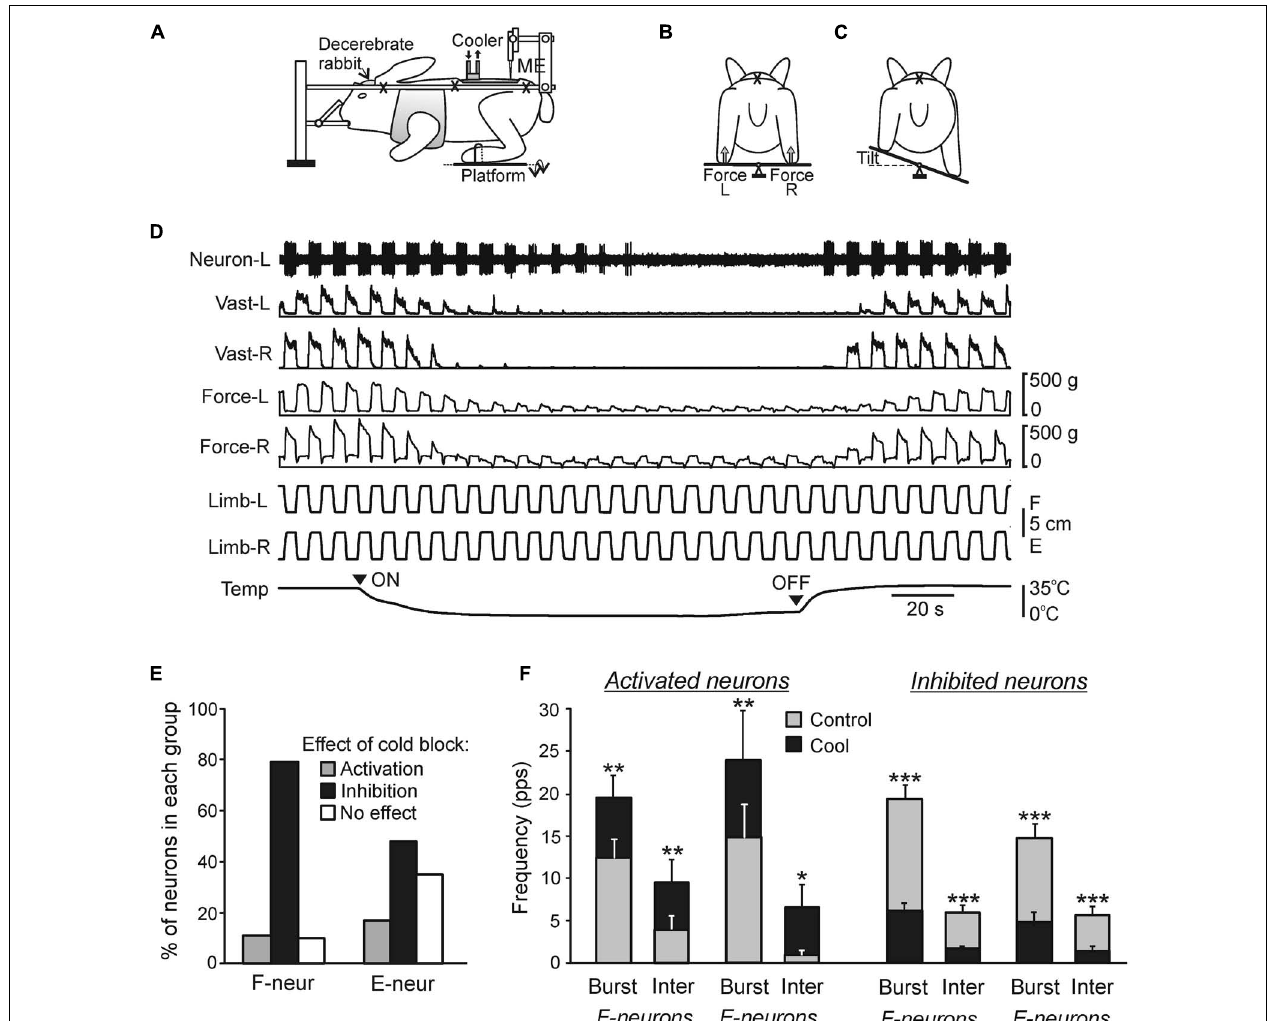
FIGURE 7 | Effects of reversible spinalization on postural limb reflexes and spinal neurons presumably mediating these reflexes. (A–C) Details of the experimental design. (A) The decerebrate rabbit was fixed in a rigid frame (crosses indicate the fixation points). Activity of spinal neurons from L5 was recorded by a microelectrode (ME). To evoke PLRs, the hindlimbs were positioned on a platform (B) periodically tilted in the transverse plane (B,C) . The contact forces under the left and right hindlimbs were measured by the force sensors ( B , Force L and Force R, respectively). (D) An example of the effect of reversible spinalization on PLRs and on the activity of a neuron recorded on the left side of spinal segment L5. During the experiment, periodical anti-phase loading/unloading and flexion/extension movements of the left and right limbs were produced by tilting the support platform. The contact force and the EMG of vastus lateralis (Vast) were